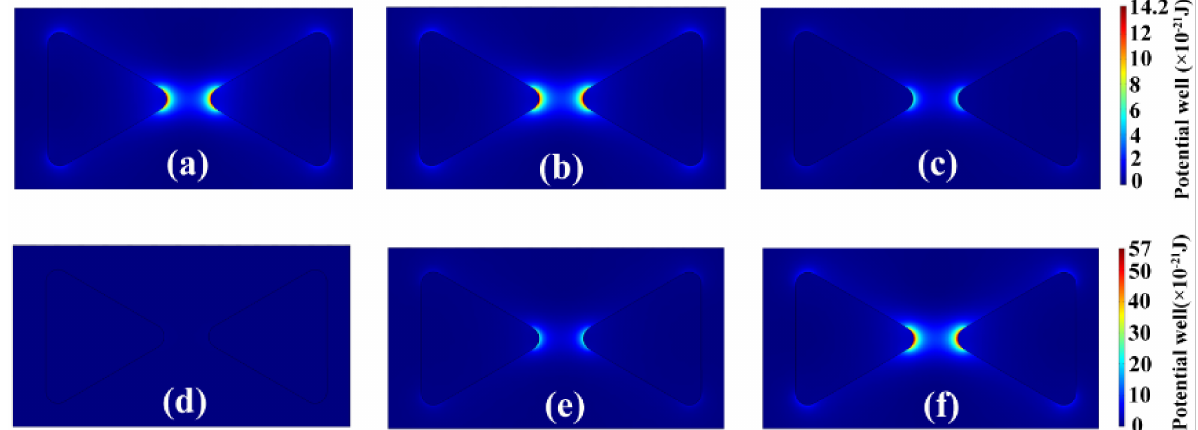
Figure 2. 2-D images of localized plasmonic trapping potential of a homogeneous Au–Au bowtie dimer at wavelengths of 545 nm ( a ), 560 nm ( b ), and 600 nm ( c ). The laser electric field amplitudes are 2 × 10 6 V/m, 4 × 10 6 V/m, and 6 × 10 6 V/m for ( d – f ), respectively. The scale bars have units of 10 − 21 J. The bowtie edge length is 20 nm, and the bowtie dimer gap is 10